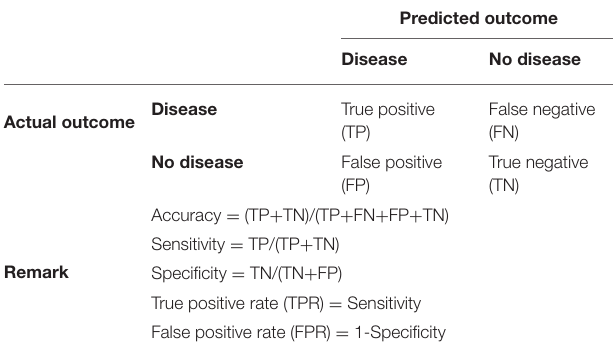
TABLE 1 | Common terminologies used to evaluate AI model